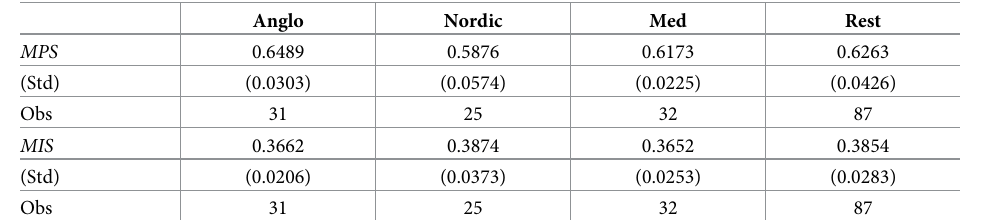
Table 5. MPS and MIS by country